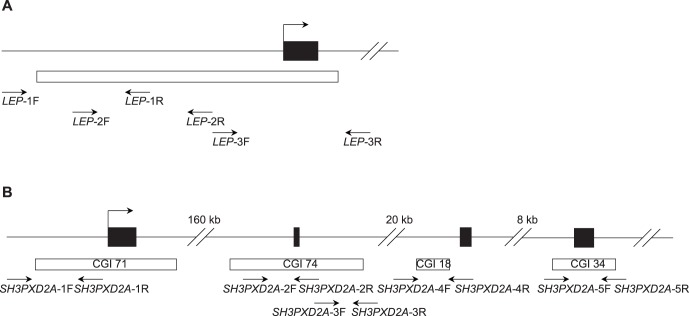
Schematic representation of LEP and SH3PXD2A gene.(A) Maps of the TSS and the proximal promoter region of the human LEP gene. Positions and orientation of the MassARRAY primers are indicated by black arrows. (B) Maps of SH3PXD2A locus presenting the CGIs region in the promoter region (CGI71) and in the gene body (CGI74, CGI18 and CGI34). Positions and orientation of the MassARRAY primers are indicated by black arrows.